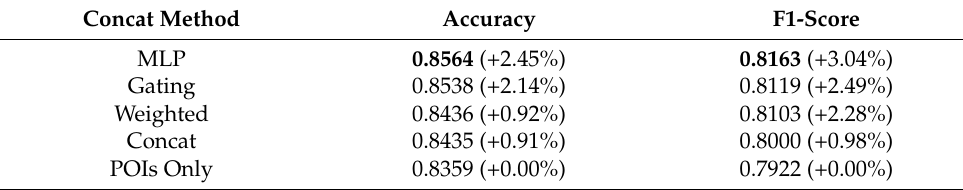
Table 14. Evaluation on store site recommendation (with additional